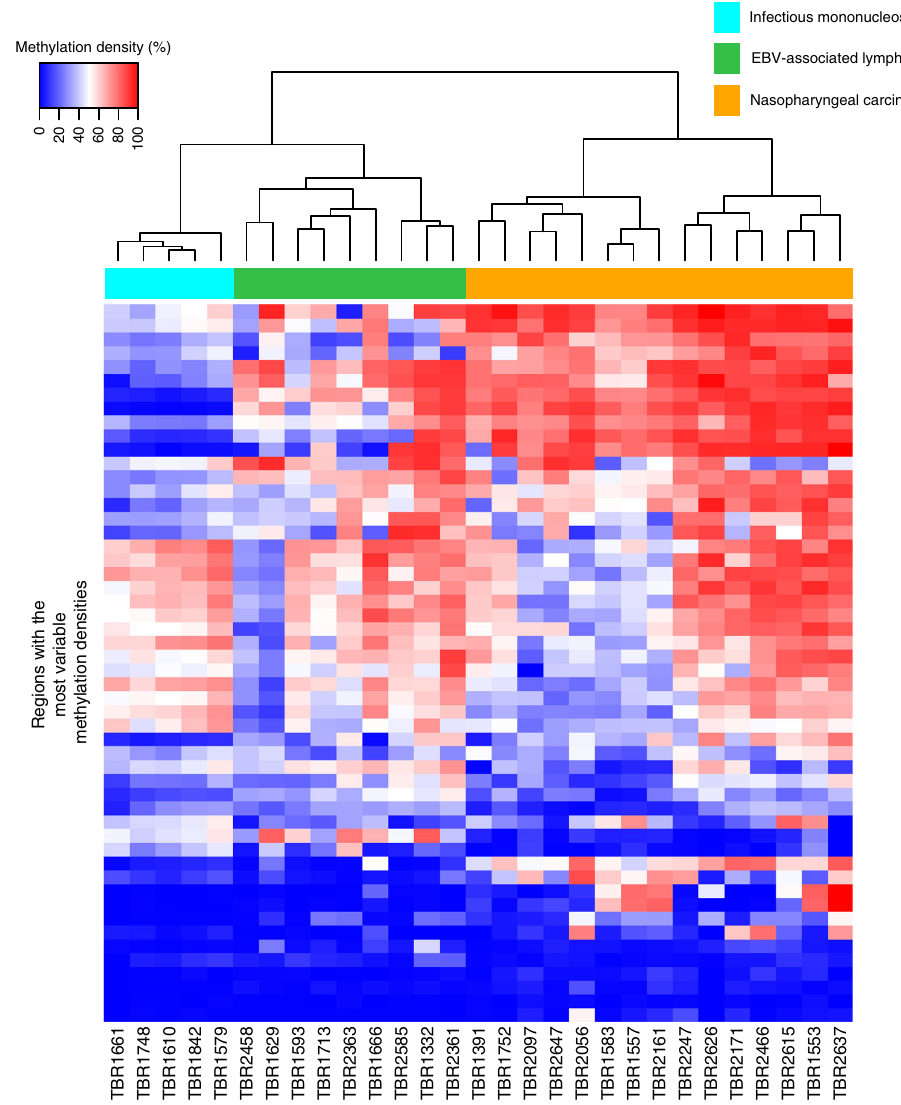
Fig. 1 Distinctive plasma EBV DNA methylation pro fi les among different EBV-associated diseases. Unsupervised hierarchical clustering analysis of plasma EBV DNA methylome for the 29 samples from patients with different EBV-associated diseases. Each vertical bar represents one plasma sample. Each horizontal bar represents the selected 500-bp regions in the viral genome which demonstrated the most variable methylation densities (coef fi cient of variation> 30%) across all 29 samples. The corresponding methylation density of each region for all samples were represented in different colours. Samples of different patients with the same EBV-associated diseases were clustered